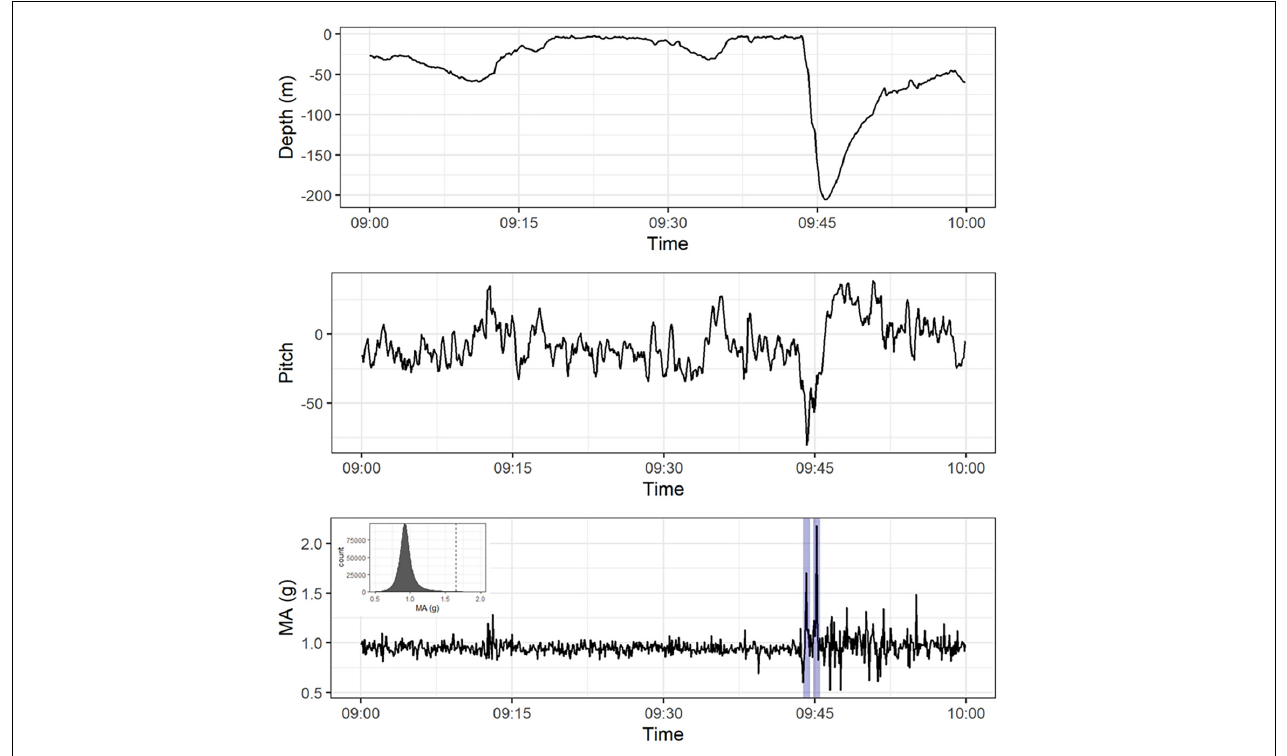
FIGURE 2 | Depth, pitch, and magnitude of acceleration (MA) for yellowfin tuna 1116009 between 09:00 and 10:00 on 22/11/2016. The blue lines in the MA chart indicate where fast starts were identified, with the inset chart showing the histogram of MA values and the dashed line reflects the threshold defined for fast